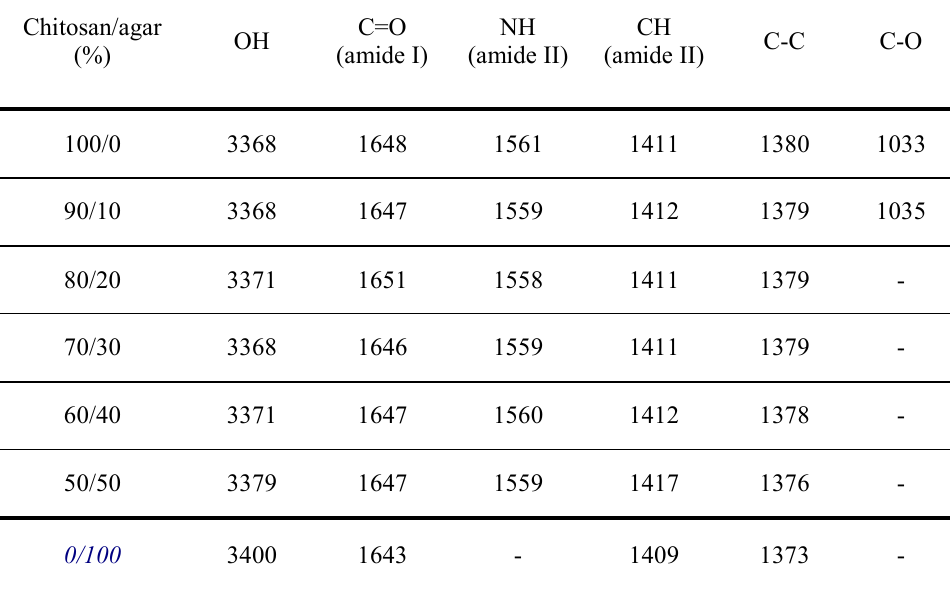
Table 1. FTIR characteristic bands of chitosan/agar blend films at various proportions.